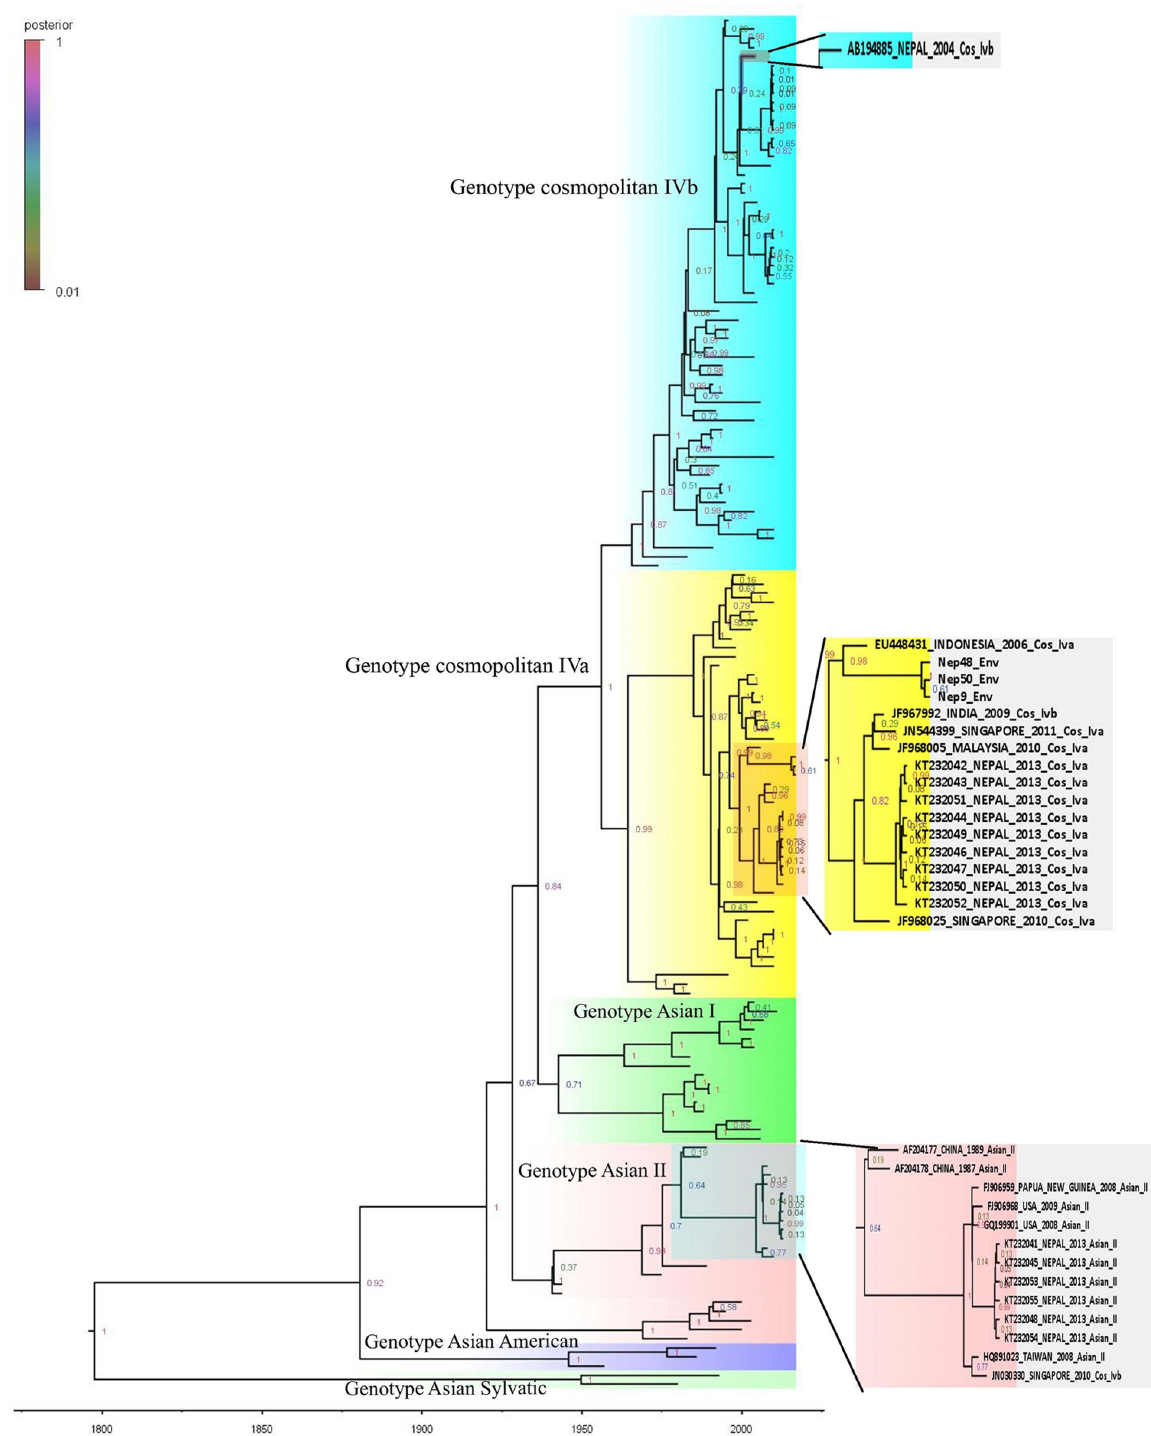
Fig 6. Phylogeny tree of DENV-2 serotype constructed using BEAST v2.5.1 using Gamma+I+T93 substitution model against Dengue genotyping database. All the sequences in the tree are labelled as; accession no._country year of isolation genotype. Tree is labelled with posterior probability at node. Highlighted area in the tree is being zoomed out at right side of figure where sequences from Nepal are shown. Detail tree with all of the sequences used for genotyping is shown in S2 Fig.